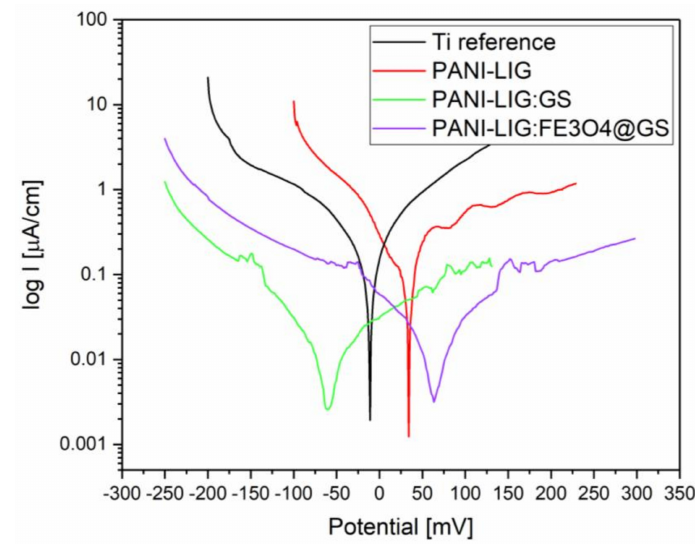
Figure 6. Tafel representation of polarization resistance obtained after immersion in simulated body fluid (SBF) (pH = 7.4). Table 3. Corrosion parameters (data extracted from the polarization curves) for bare Ti, PANI-LIG:Gentamicin sulfate (GS) and PANI-LIG:Fe 3 O 4 @GS coatings deposited on Ti. Type of